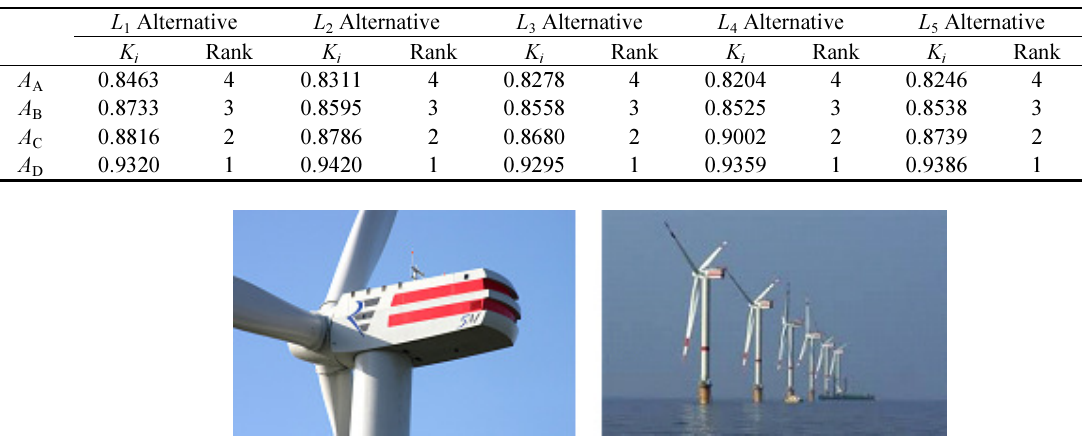
Table 10. Solution results